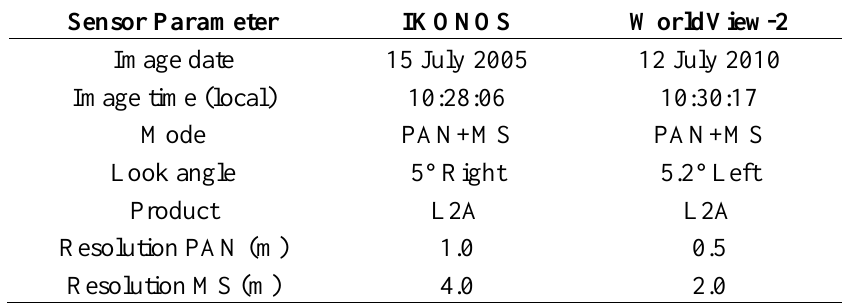
Table 1. Scene parameters for Ikonos and WorldView-2 data over the city of Munich,